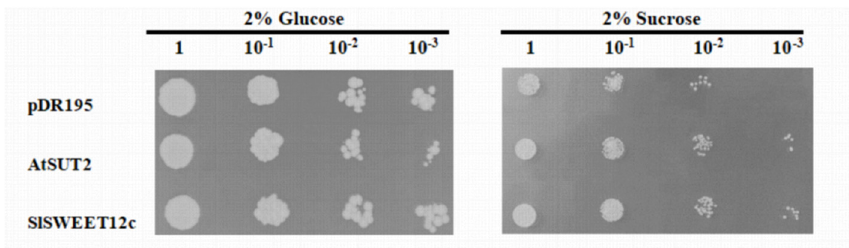
Figure 4. Transport activity of Sl SWEET12c in yeast strain SUSY7/ura. SlSWEET12c , yeast sucrose transporter ( AtSUT2 ), or empty vector (pDR195) were grown on synthetic deficient (SD)/-uracil solid medium containing 2% glucose or 2% sucrose as the sole carbon source. Representative results of experiments repeated at least three times are shown.